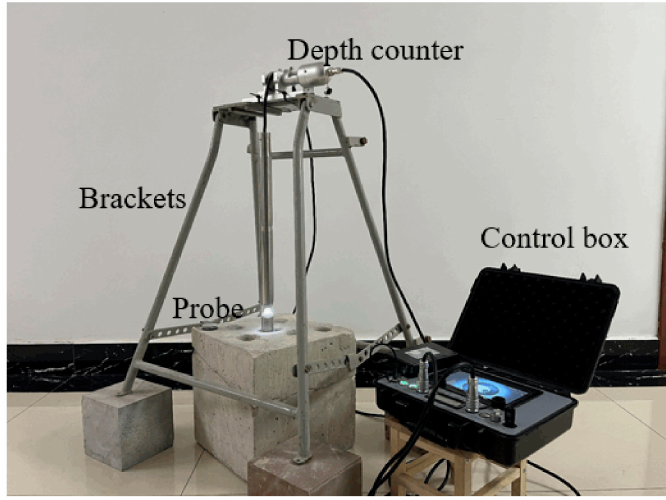
Figure 9. Data acquisition using digital panoramic borehole